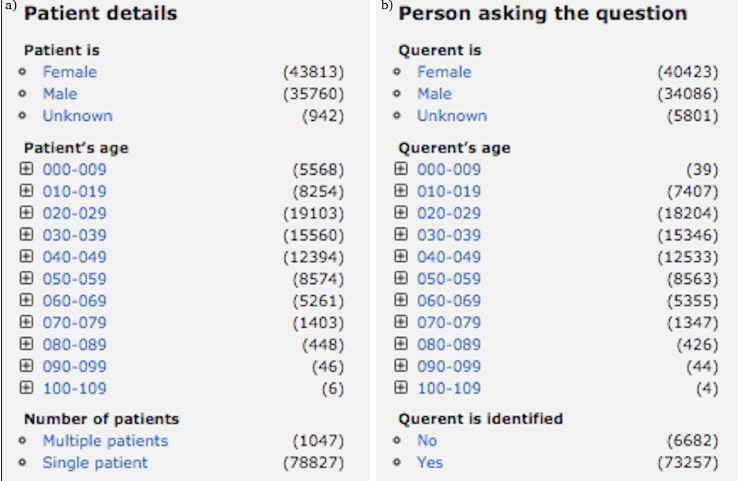
Figure 8a and b: Facets for ages of patients and querents from the full corpus of cases. Lauren Kassell,